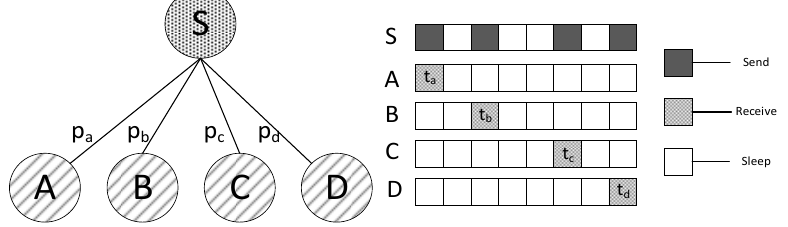
Figure 1. Traditional code diffusion scheme.